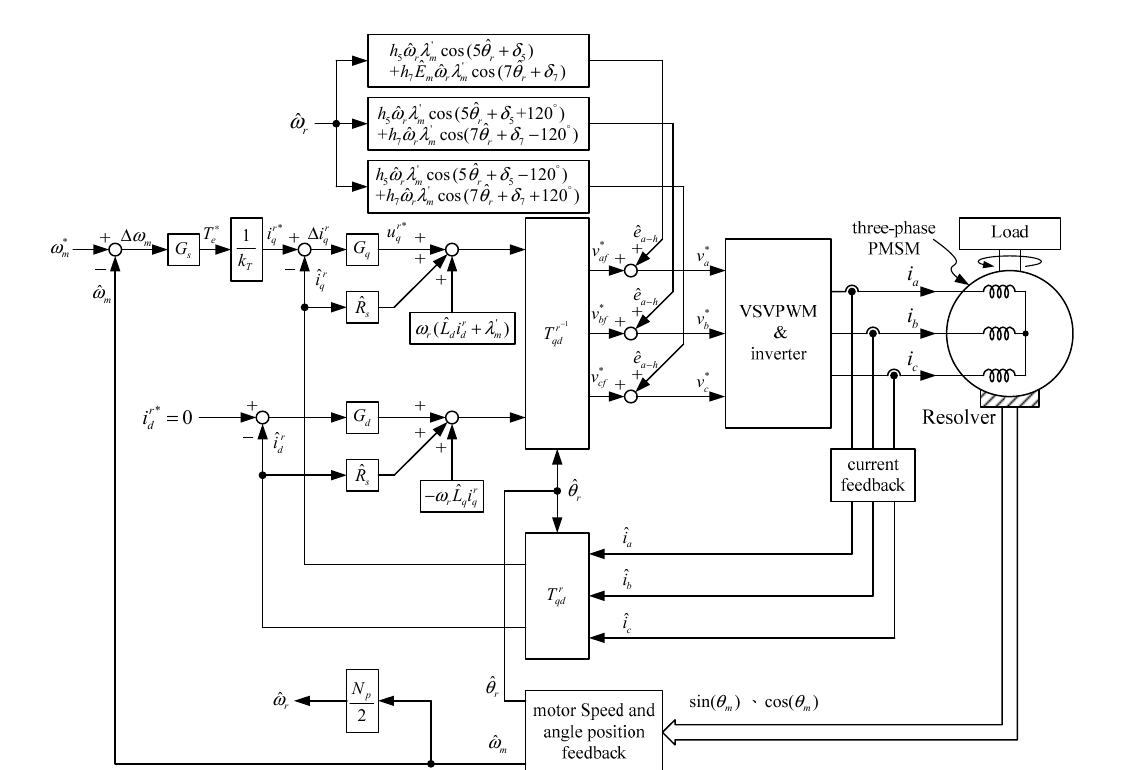
Figure 2. Current harmonics improvement control block of compensation for the induced electromotive force (EMF) harmonics along the a-axis, b-axis, and c-axis in the q-axis/d-axis current closed-loop control. Energies 2021 , 14 , x FOR PEER REVIEW